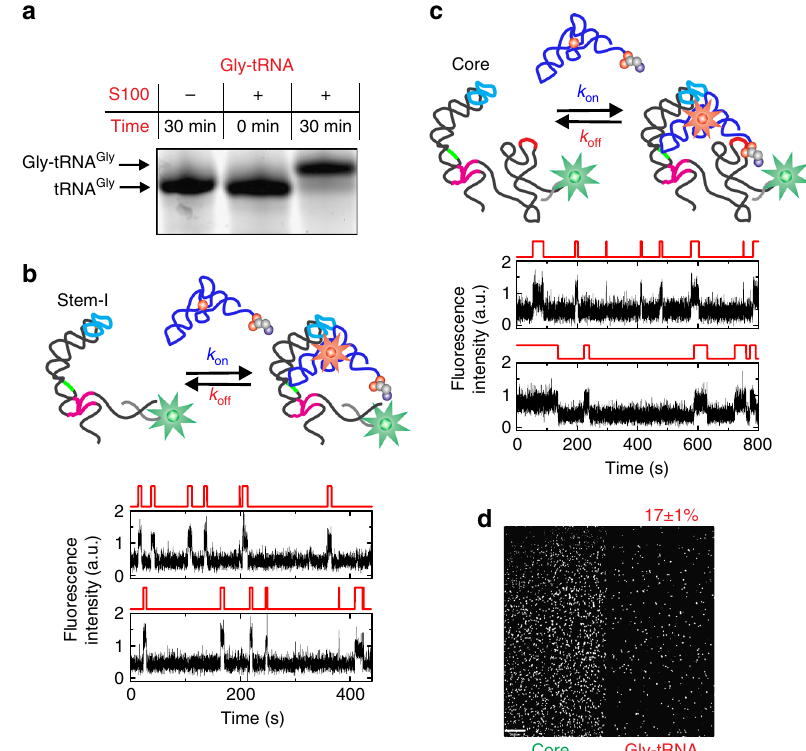
Fig. 6 Effect of aminoacylation on the tRNA binding kinetics. a Acid-urea PAGE showing high-ef fi ciency of tRNA aminoacylation using E . coli S100 extracts. Schematic and representative single-molecule traces showing Gly-tRNA Gly binding to b Stem-I and c the core T-box riboswitch. d Average image of fi rst 30 frames (3 s) for Gly-tRNA Gly binding to the core T-box construct. Approximately 17% of Gly-tRNA Gly molecules are in ultra-stable